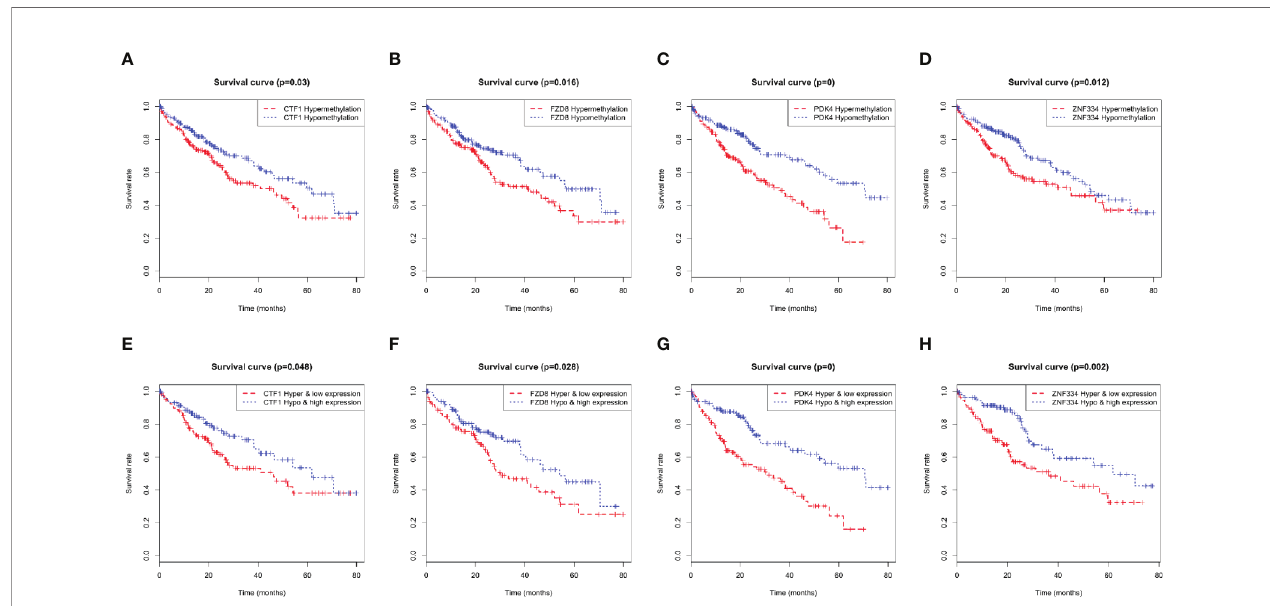
FIGURE 6 | Kaplan-Meier curves for methylation expression of MeDEGs are associated with overall survival. (A) CTF1, (B) FZD8, (C) PDK4 and (D) ZNF334 were ranked by the median of methylation and then scored for each patient in accordance with high- or low-level methylation value. (E) CTF1, (F) FZD8, (G) PDK4 and (H) ZNF334 were ranked by the median of methylation and expression and then scored for each patient in accordance with high- or low-level methylation value and high or low-level expression value. The horizontal axis represents the overall survival time and the vertical axis represents survival function.